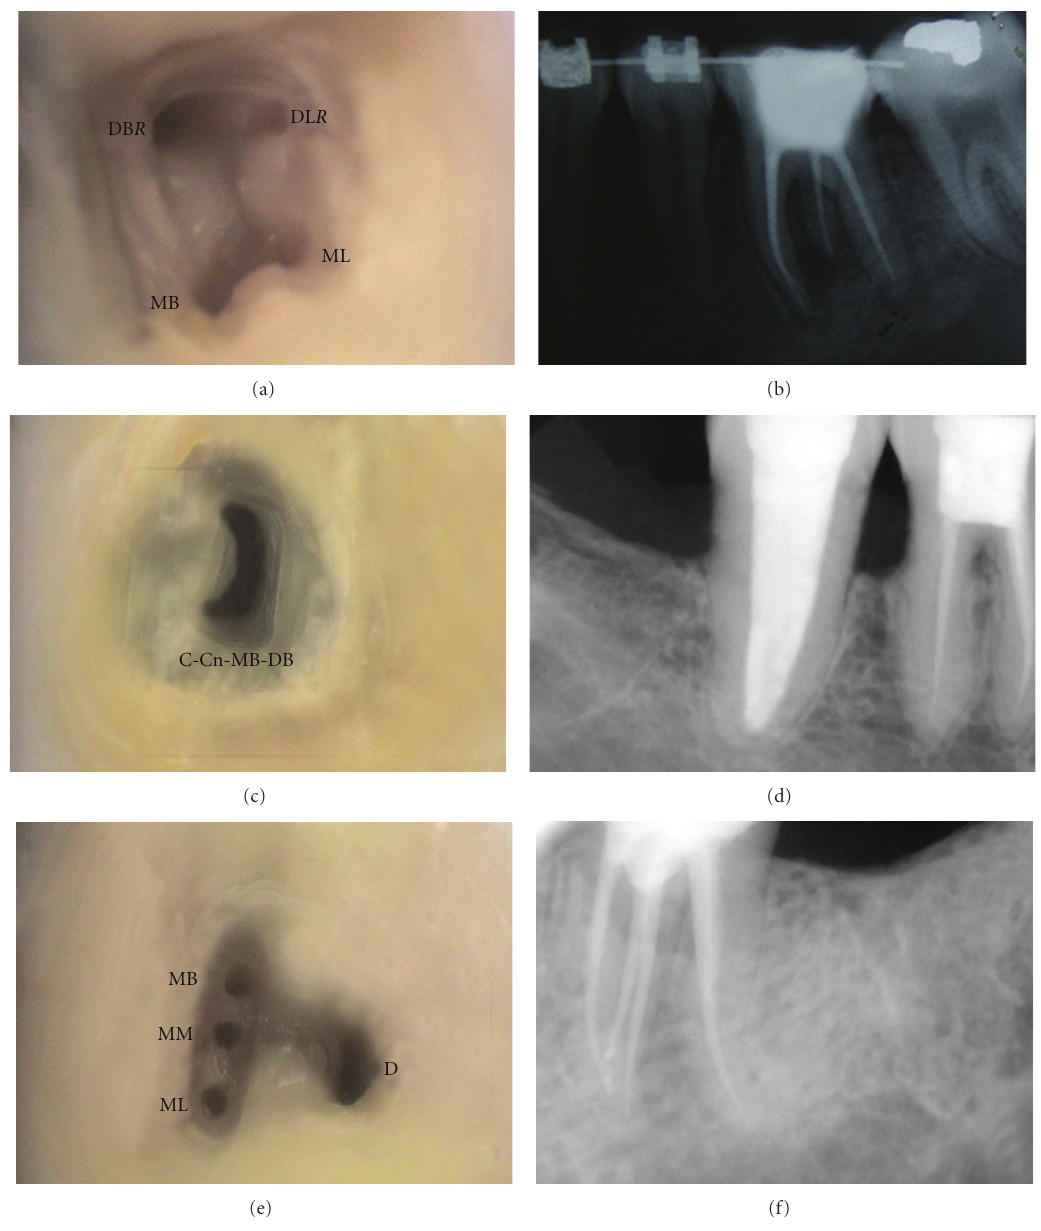
Figure 5: Clinical and radiographic images of anatomic aberrations demonstrating the use of the proposed nomenclature. (a, b) Pulp chamber floor showing an additional distolingual root and canal (DL R ) and the distobuccal canal (DB R ) in the distobuccal root; MB— mesiobuccal, ML—mesiolingual. (c) C-shaped centrally located (Cn) canal extending from the mesiobuccal (MB) to the distobuccal (DB) portion of the tooth; within a single root (d). (e, f) Three canals in the mesial root of a mandibular first molar; MM—middle mesial,